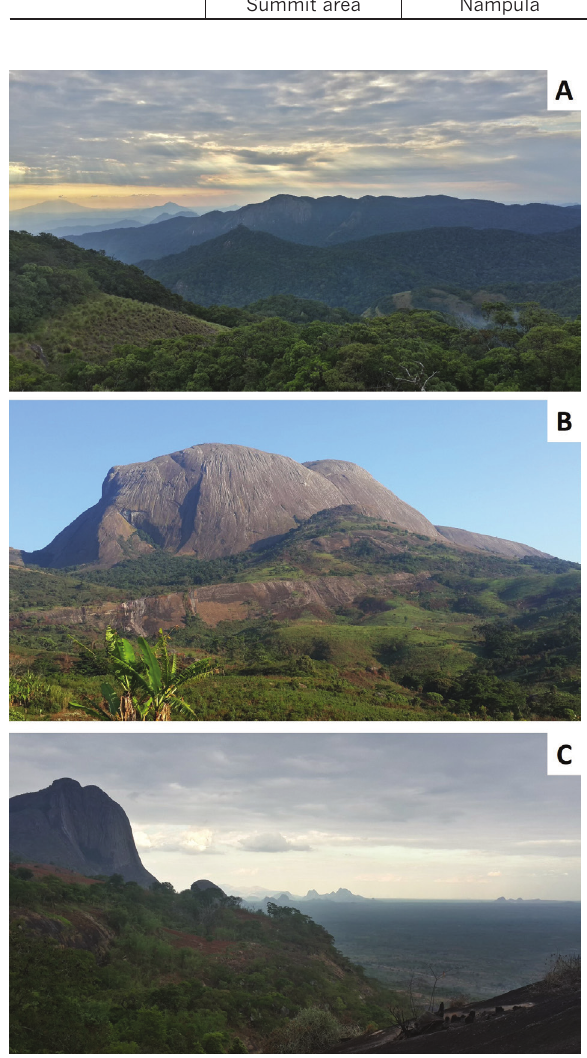
Figure 2. Study area, northern Mozambique sky islands. A – Mount Mabu, B – Mount Namuli, C – Mount M’pàluwé to the left. internal fragmentation of the forest due to slash and burn clearing. The summits are characterised by bare granitic rocks with isolated patches of montane heath vegetation. Temporary streams are found in all three mountains but no permanent stream was found in Mt.